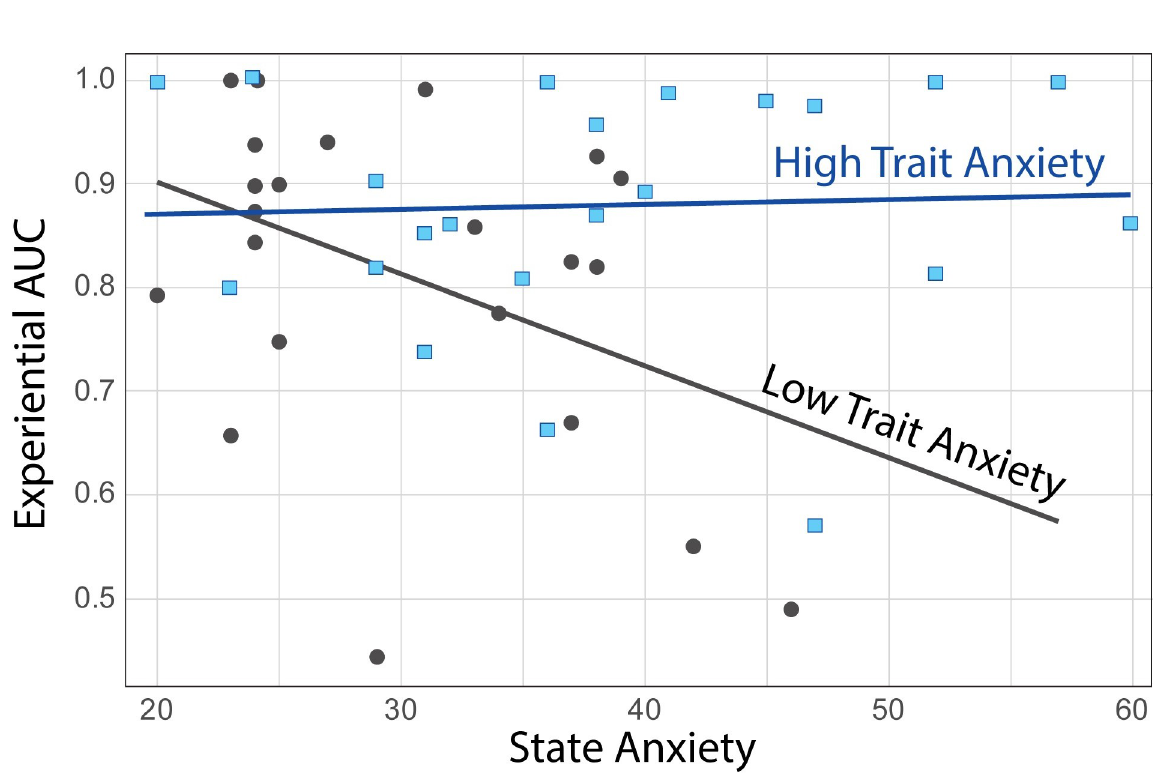
Fig 10. Illustration of the interaction between state anxiety and trait anxiety on AUC during the experiential intertemporal choice task. A split-half method was employed over the trait anxiety distribution. AUC stands for Area Under the Curve, with greater AUC implying greater willingness to wait for the delayed reward. Solid black circles correspond to data for individuals with lower trait anxiety; and blue squares to data for individuals with higher trait anxiety.